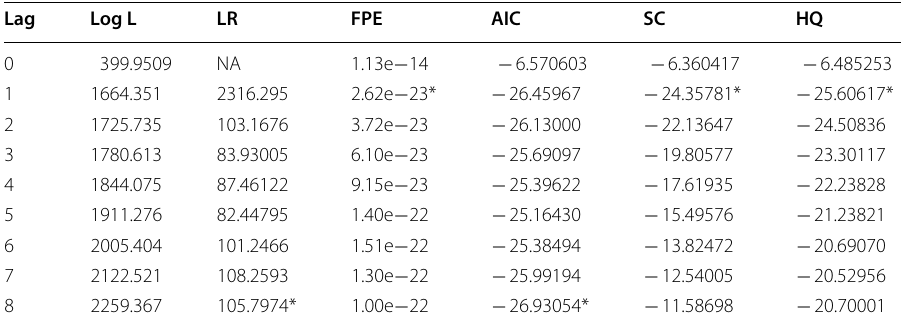
Table 3 Lag selection criterion